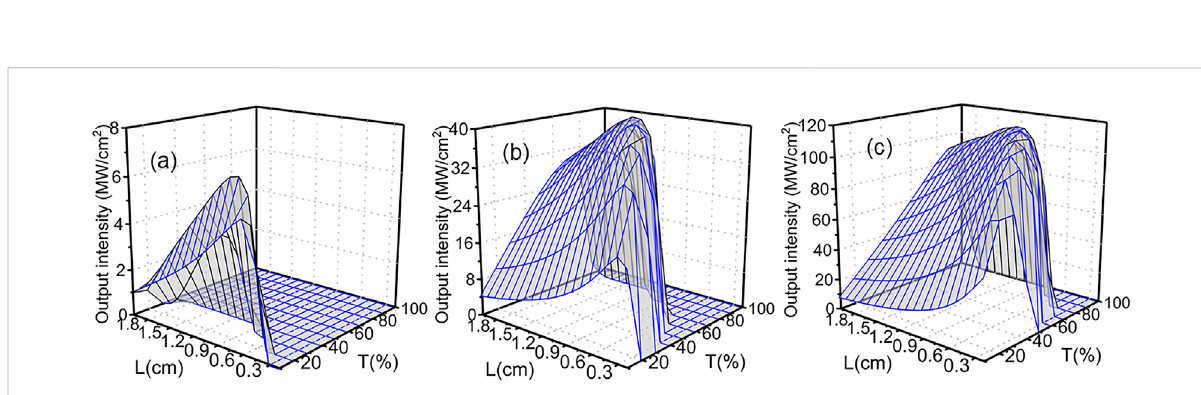
Threshold intensity versus L for various output facet transmittances with different pump